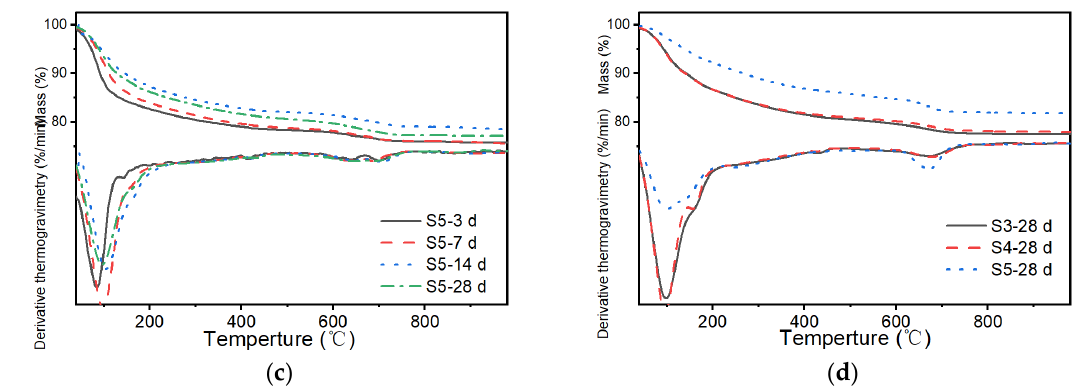
Figure 4. Thermal analysis at different ages for ( a ) S3, ( b ) S4, and ( c ) S5, and ( d ) thermal analysis of different samples at 28 days. Table 5. Quantitative thermal analysis of the weight loss in samples S3–S5 at different ages (wt%). Temperature